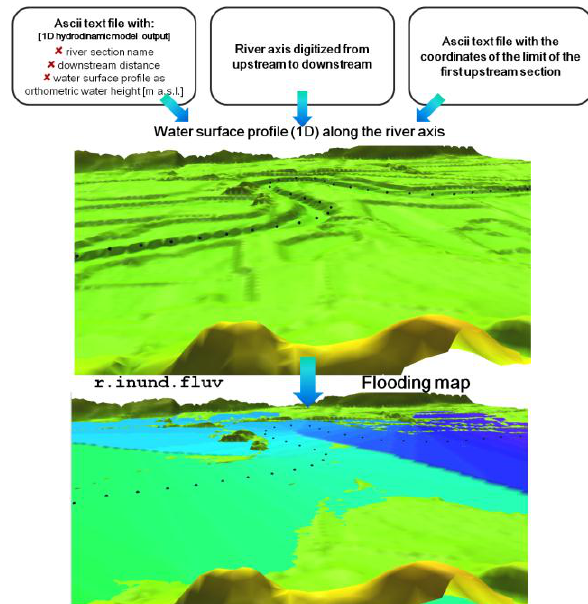
Figure 2. The result of a 1D hydrodynamic model (a water surface profile along the river axis) is used as input of the r.inund.fluv GIS module to obtain flooding